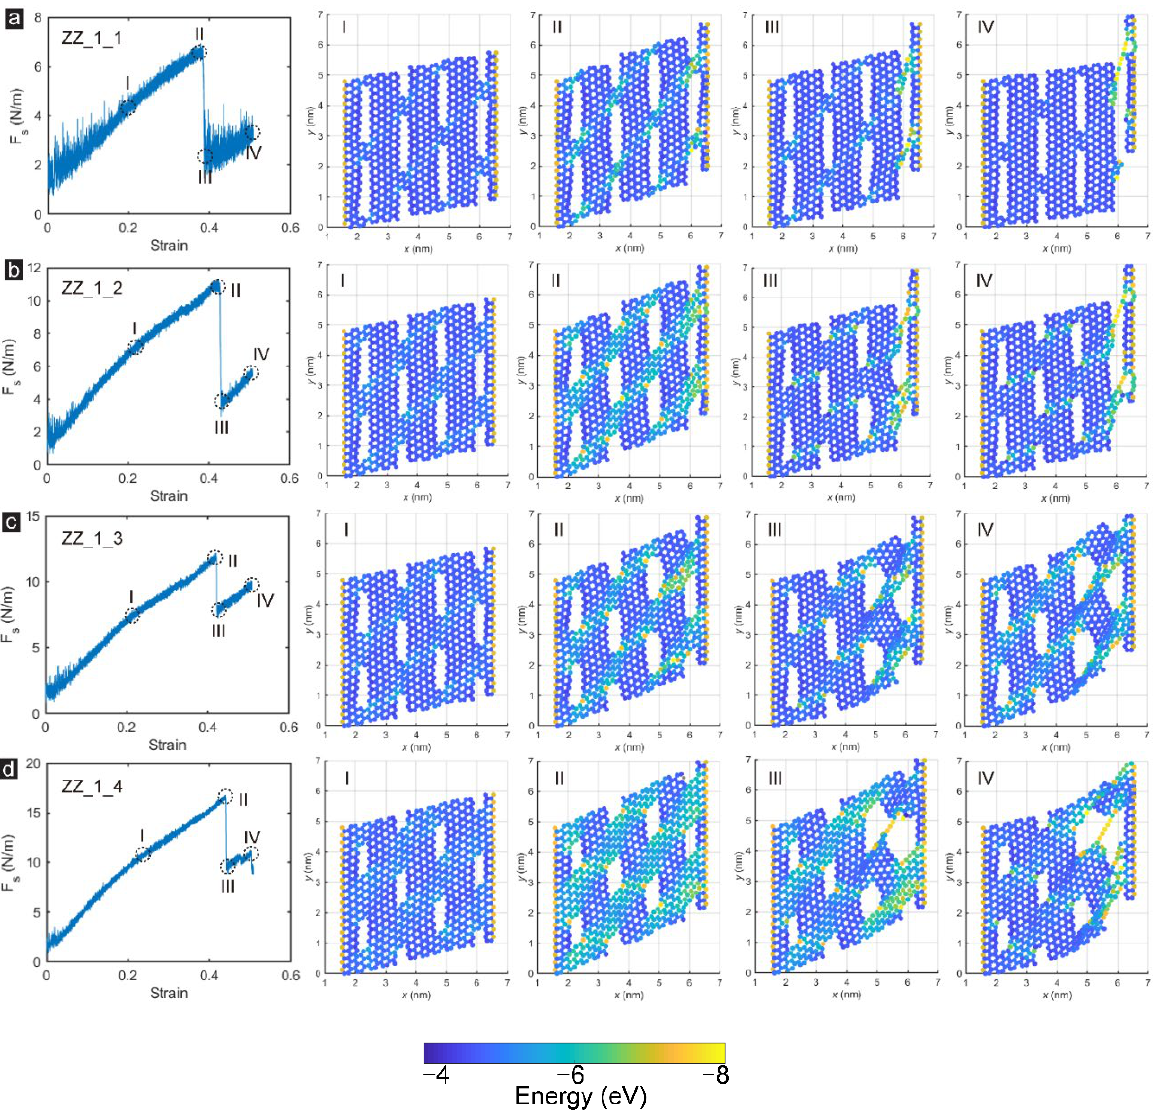
Figure 3. The snapshots of the microstructural damage processes and failure characteristics of zigzag-incised GK membrane: Sample ( a ) ZZ_1_1; ( b ) ZZ_1_2; ( c ) ZZ_1_3 and ( d )